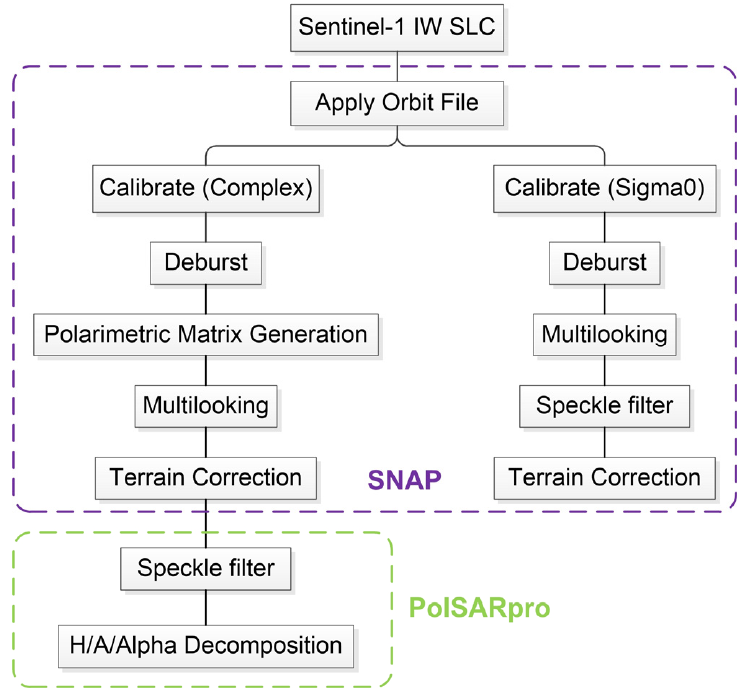
Figure 3. Flow chart of SAR data preprocessing and parameter extraction.